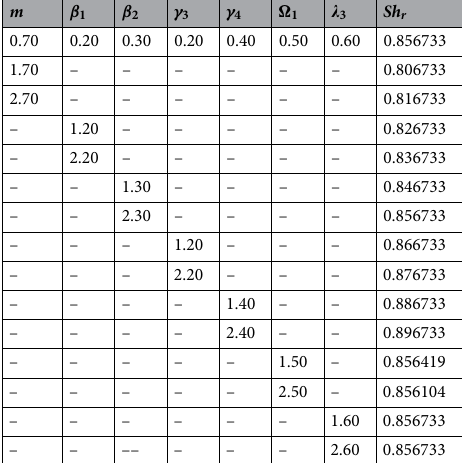
Table 4. Numerical values of Sherwood